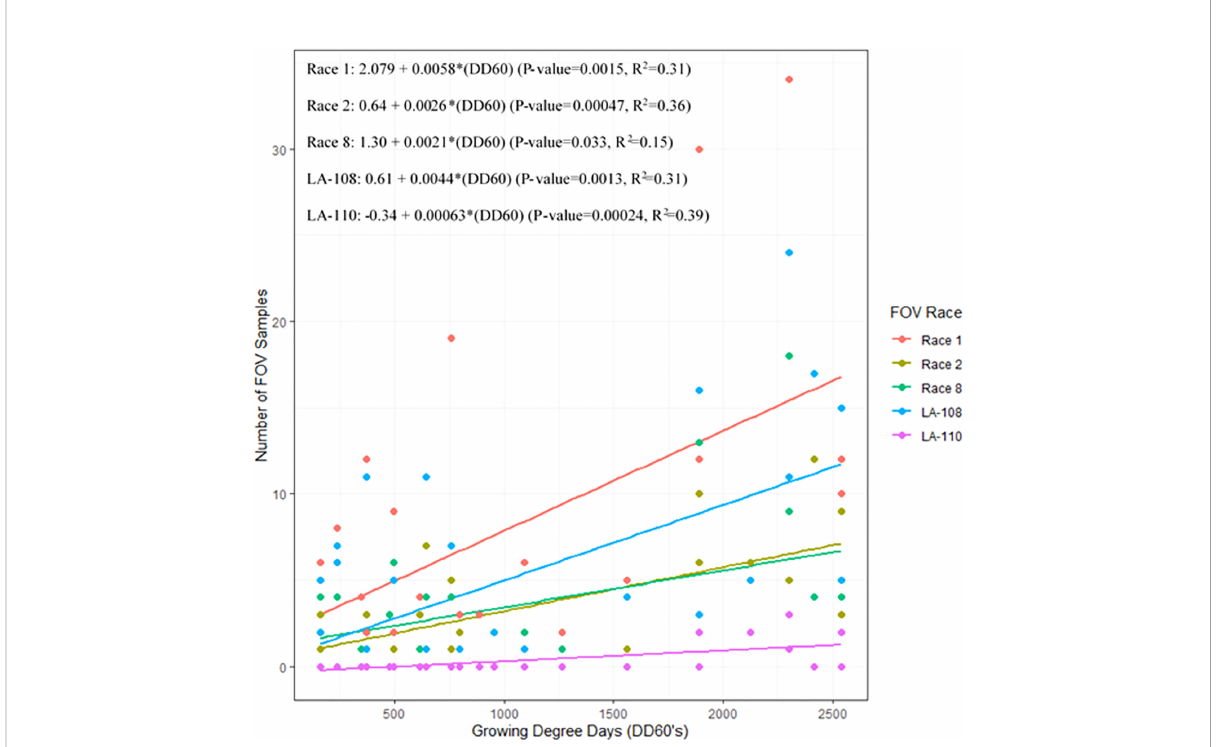
FIGURE 7 The 2018 and 2019 temporal distribution of Fusarium oxysporum f. sp. vasinfectum (FOV) throughout the cotton growing season. Graph shows the linear relationship between the number of FOV samples collected and the accumulation of growing degree days (DD60 ’ s). Linear relationships for race 1 race 2, race 8, LA-108, and LA-110 are shown. Other races and genotypes found in this study did not have a signi fi cant relationship with accumulation of DD60 ’ s and therefore are not shown in this fi